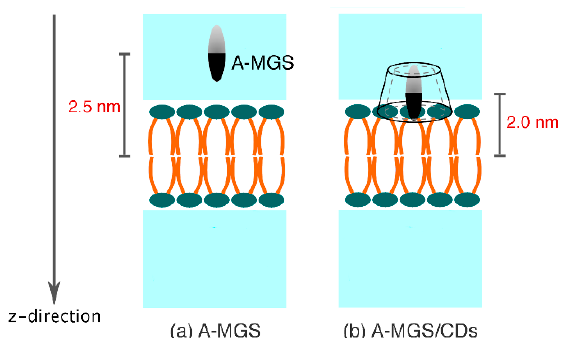
Figure 10. Schematic models of each system for MD umbrella sampling simulations: ( a ) free A-MGS is initially set by placing in the water phase, while ( b ) the inclusion complexes were positioned at the polar head groups of the POPC membrane. Table 2. Details of the overall simulation models for the potential mean of force (PMF) calculations of the A-MGS, A-MGS / β CD, and A-MGS / DM β CD.